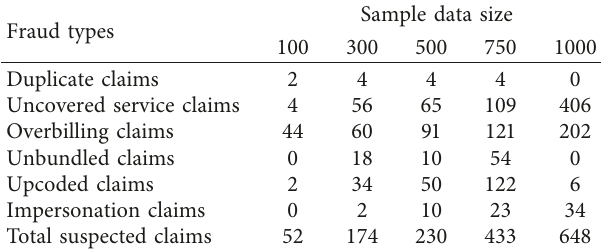
Table 2: Sample data size and the corresponding fraud types.